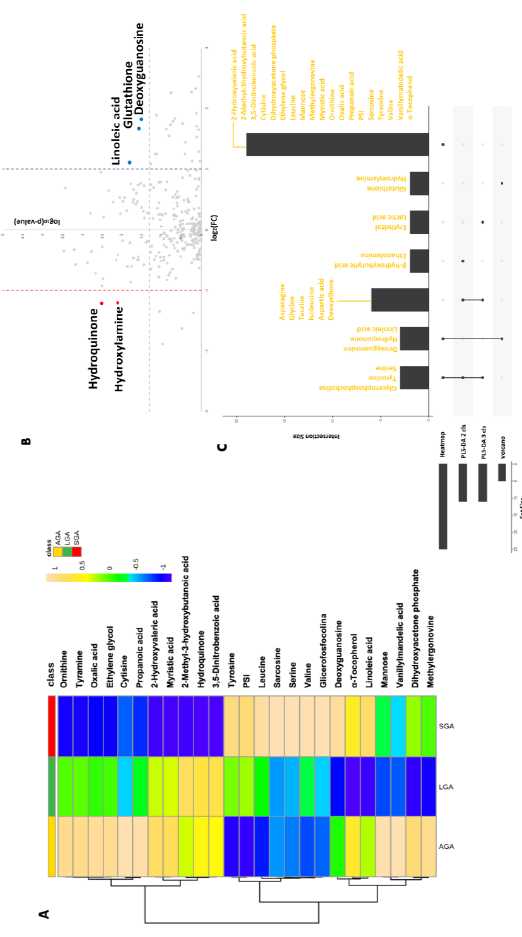
Figure 2. Relevant metabolites selected in all class comparisons. ( A ) Heatmap reporting the ANOVA selected metabolites. Cluster analysis allowed for the recognition of three groups of metabolites based on their concentration mean levels in the three classes (SGA: small for gestational age; AGA: adequate for gestational age; LGA: large for gestational age). ( B ) Volcano plot of the analyzed metabolites comparing LBW to non-LBW placentae, highlighting the ones showing a p -value < 0.05 and a large fold change (>2.0 or <0.5); in red are the metabolites with a lower concentration in LBW, while in blue are the metabolites with a higher concentration in LBW. ( C ). UpSet diagram reporting the relevant metabolite selection among the various strategies. Set size indicates the number of metabolites involved in each metabolite selection strategy, while intersection size indicates the number of metabolites selected from each strategy combination.